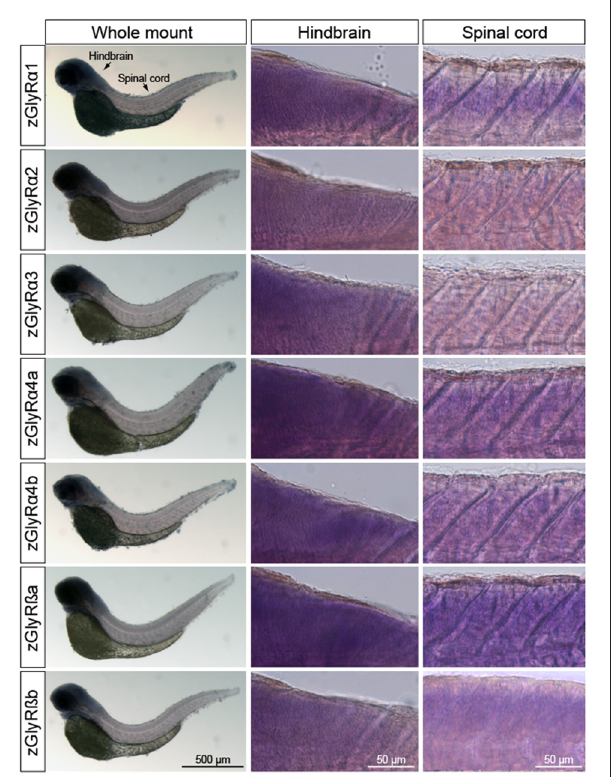
FIGURE 3 | Whole-mount in situ hybridizations of zGlyR subunits from 48 hours post-fertilization (hpf) larvae. Individual subunits are indicated to the